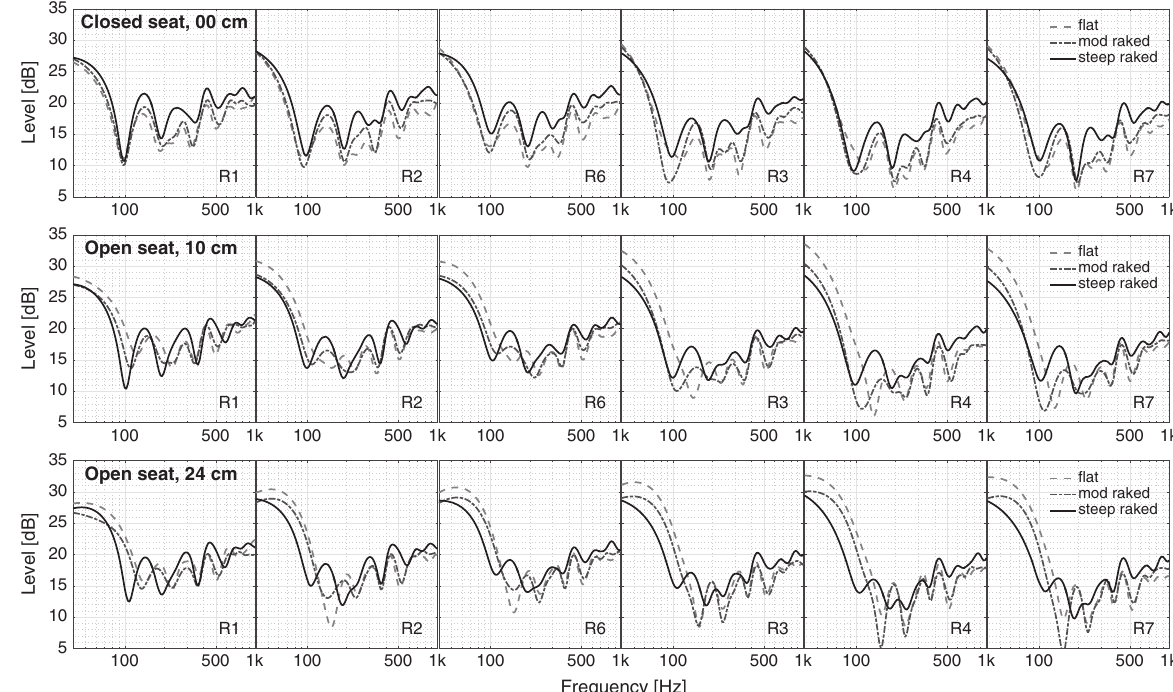
Figure 5. The 1/3-octave smoothed magnitude responses at 15 ms after the direct sound after calibration at 10 m and compensation for spherical divergence. The responses show the effect of fl oor raking across seat